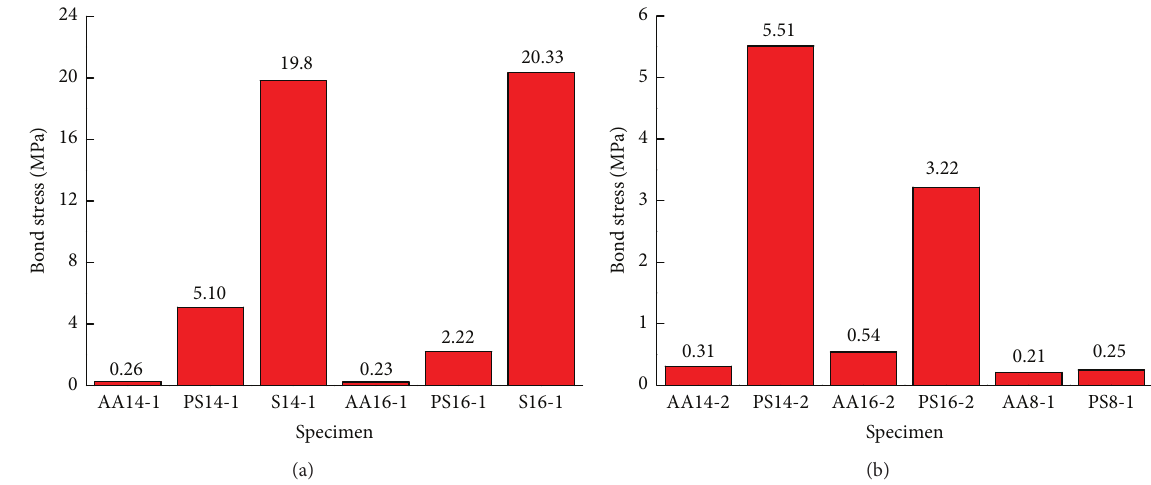
Figure 6: Effect of type of bar surface on bond strength: (a) length of embedment of 7 d and (b) length of embedment of 10 d.